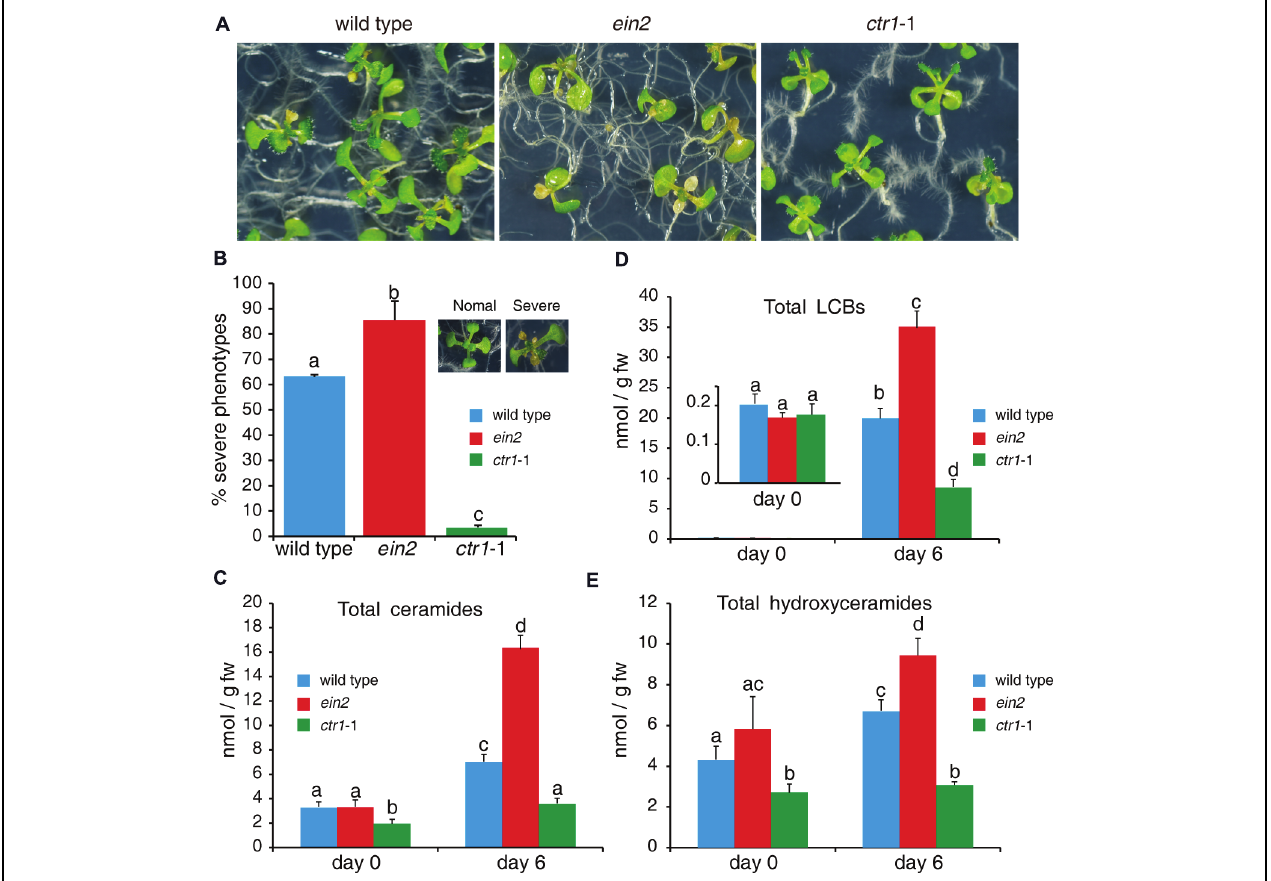
FIGURE 5 | Sphingolipid profiles of wild-type, ein2 , and ctr1 -1 seedlings during FB1 treatment. Seven-day-old seedlings were treated with 0.5 µ M FB1 and collected after 6 days. Total sphingolipids were extracted and analyzed by LC–MS system. (A) Phenotypes of FB1-treated seedlings. Photos were taken after 6 days of treatment. (B) Quantitation of the phenotypes in (A) . Seedlings with lesions were scored as having a severe phenotype. The data represent at least three independent experiments. More than 100 seedlings were counted. (C–E) Comparisons of different kinds of sphingolipids in wild-type, ein2 , and ctr1 -1 seedlings. Data represent means ± SD from three independent biological experiments and sets marked with different letters indicate significances assessed by Student–Newman–Keul test ( P < 0.05). (C) LCBs. (D) Ceramides. (E) Hydroxyceramides. See Supplementary Figure S1 for the detailed analysis.